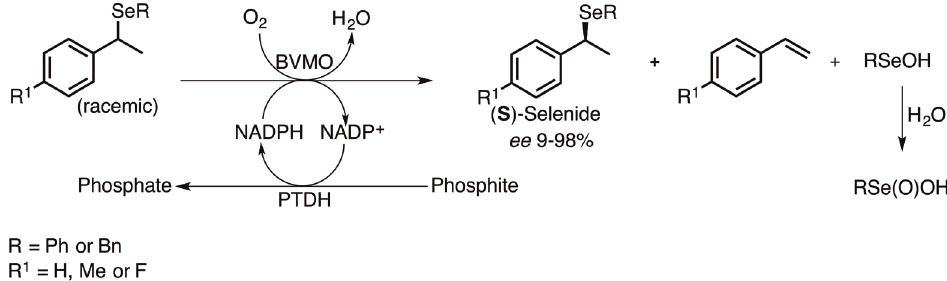
Figure 46 - Kinetic Resolution of aromatic selenides using BVMOs as